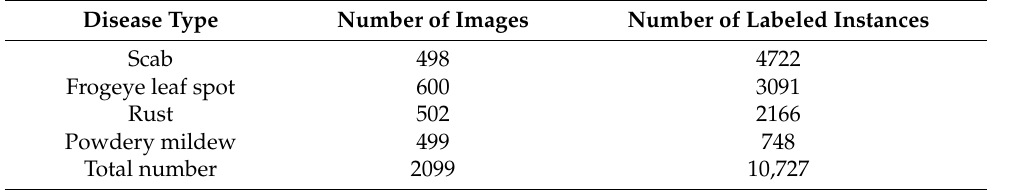
Table 1. Label distribution of